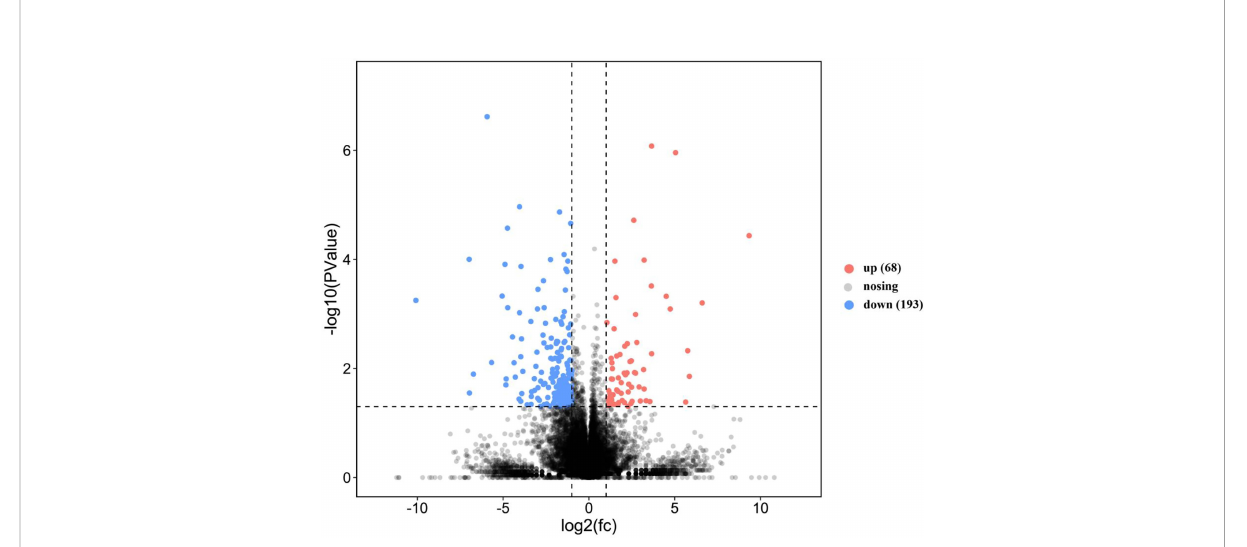
FIGURE 2 Volcano plot of the differentially expressed genes in the ovary of adult spotted scat fed with different oil sources.